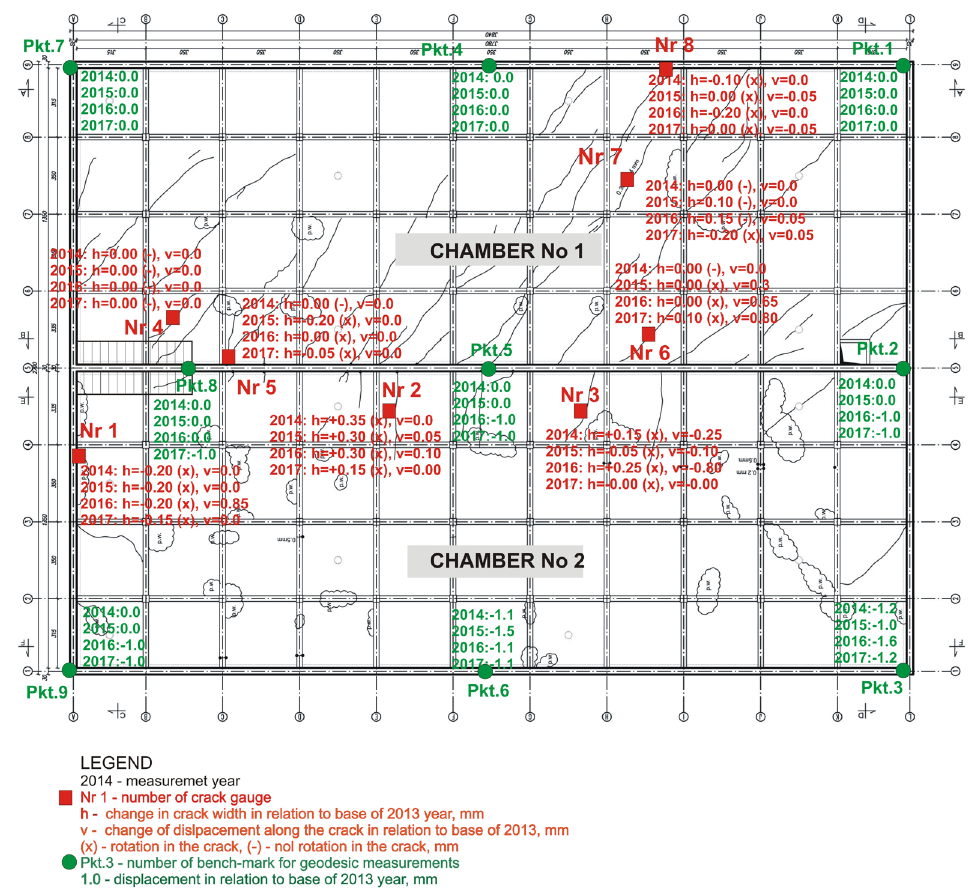
Figure 11: The location of crack gauges and places of vertical displacement surveying and the measurement results in